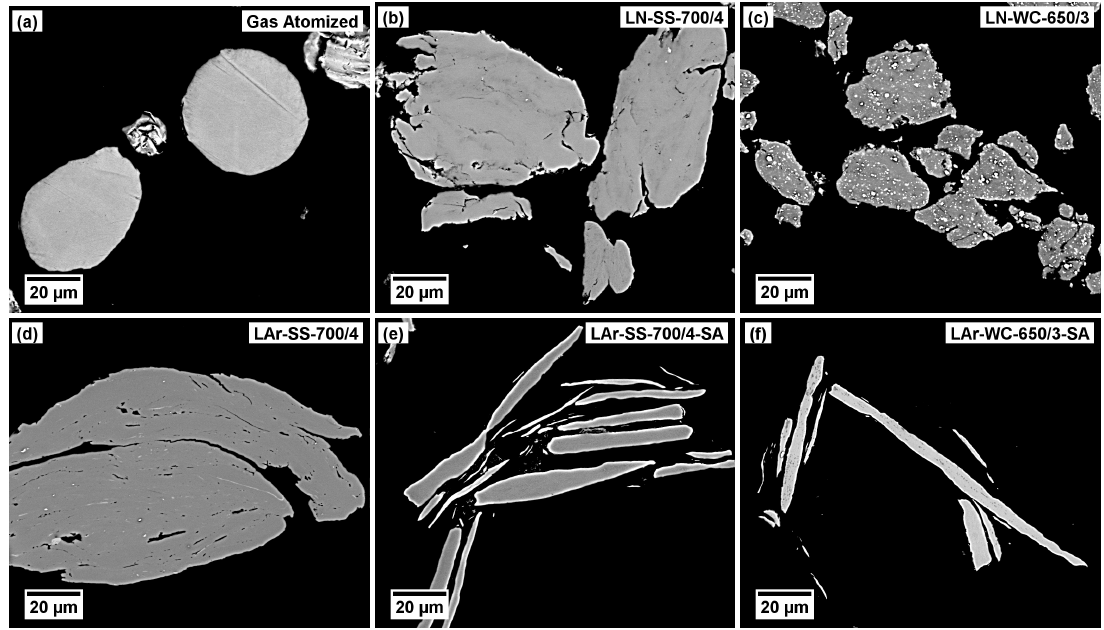
Figure 2. SEM micrographs of powder cross-sections: ( a ) gas-atomized; ( b ) LN, SS balls, 4 h; ( c ) LN, WC-Co balls, 3.25 h; ( d ) LAr, SS balls, 4 h; ( e ) LAr, SS balls, 4 h, with SA; ( f ) LAr, WC-Co balls, 3.25 h, with